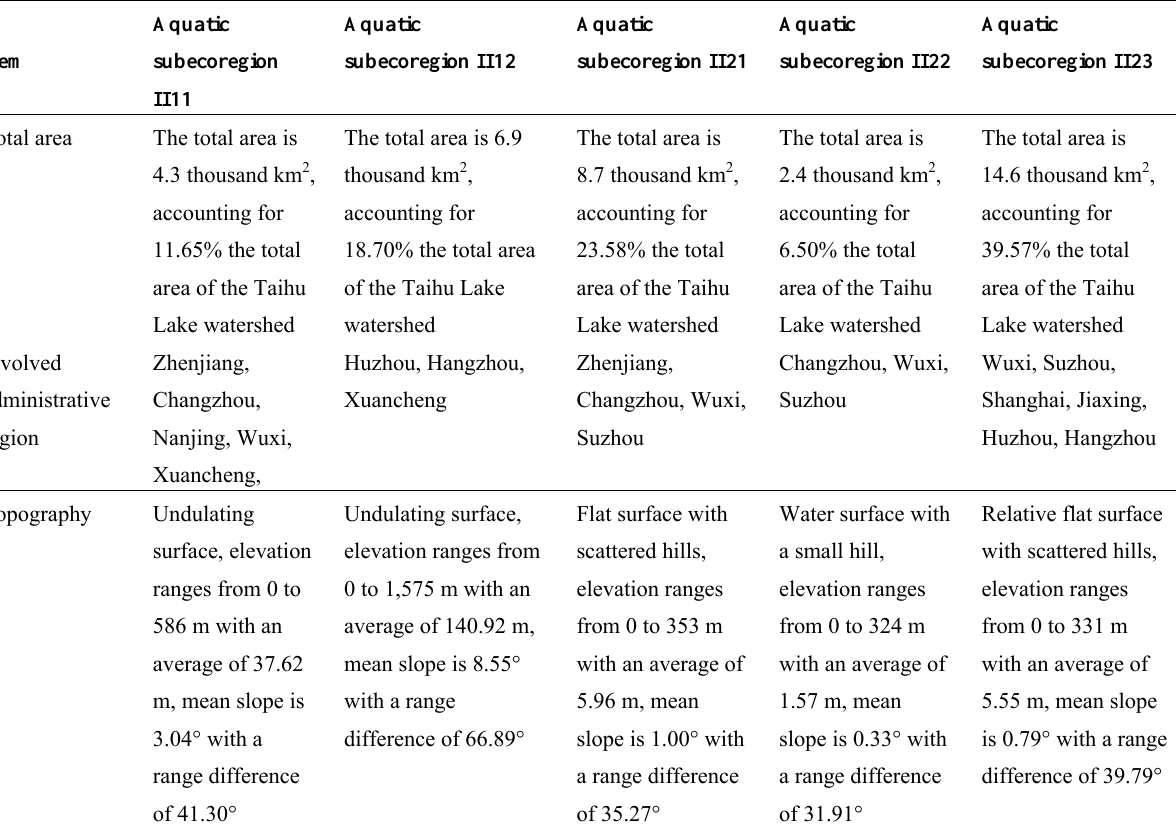
Table 3. General characteristics of the five level II aquatic subecoregions in Taihu Lake